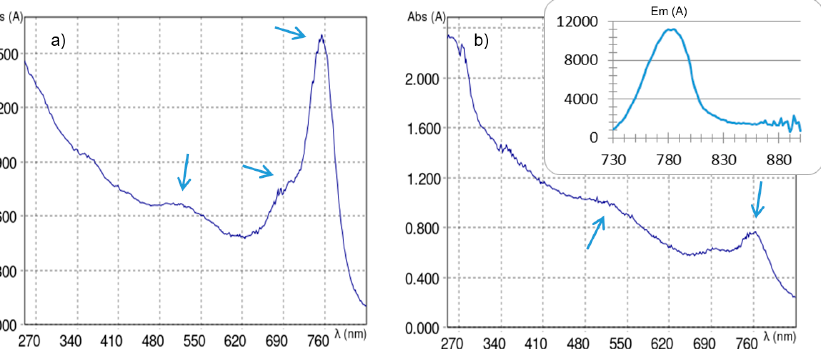
Figure A9. Absorption spectra of AuNP-RGD-NIR-dye 8 ( a ) after dialysis and ( b ) after additional Sephadex purification (A spr = 0.668/A 480 = 0.660 gives 1.01 → 3 nm) with three absorption maxima at 534, 690, and 750 nm. Insert in ( b ): Corresponding emission spectrum (excitation wavelength = 690 nm, emission = 740–840 nm, Em Max = 790 nm).